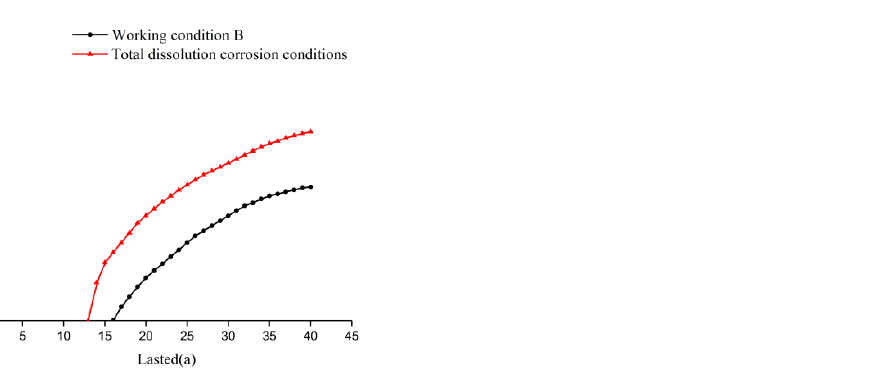
Figure 16. Variation in pore pressure value at the bottom of the culvert with dissolution time for working condition B and full dissolution working condition (kPa).